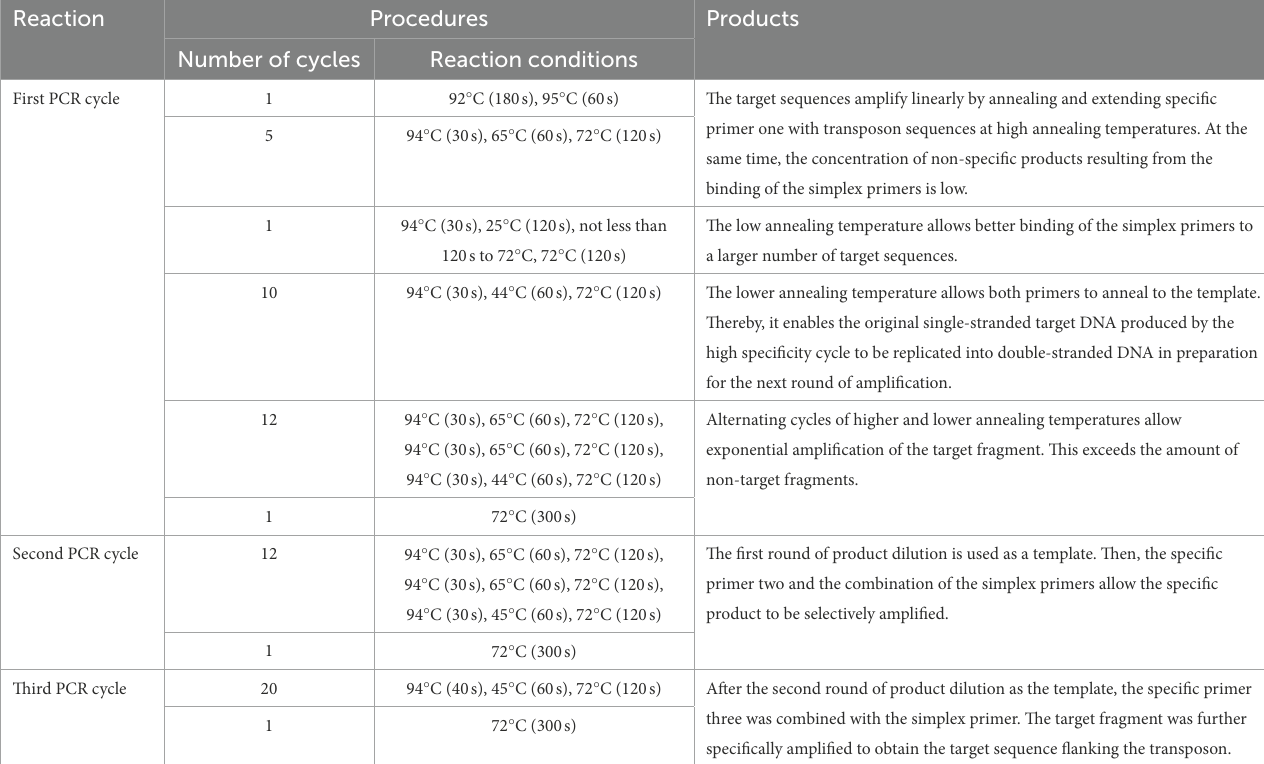
TABLE 1 TAIL PCR amplification procedures. Reaction